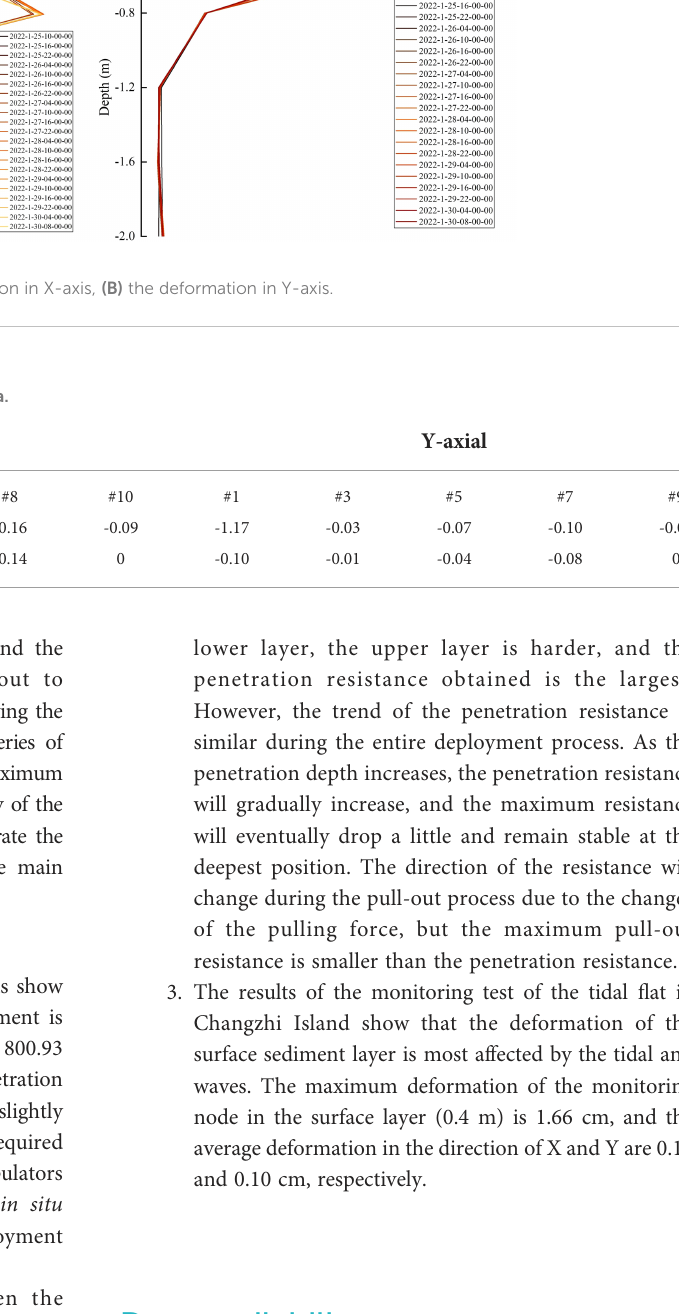
FIGURE 14 Deformation of the monitoring instrument. (A) the deformation in X-axis, (B) the deformation in